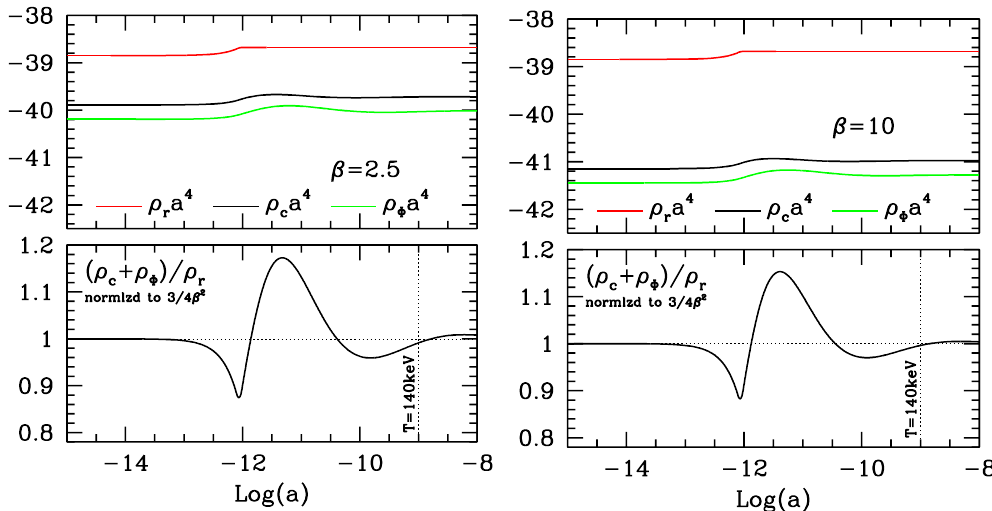
Figure 7. QH transition causes oscillations of the early density parameters Ω c = 2 Ω Φ = 1/2 β 2 . The system of Equation (11), when ρ r is given by expression (7), yields the results shown here for β = 2.5 and 10. In the upper frames, the logarithms of ρ r , c , Φ a 4 are plotted. Their deviation from the constant is also outlined in the lower frames. The normalized ratio ( ρ c + ρ Φ ) / ρ r exhibits a mild β dependence, in the initial oscillations, with maximum deviation by ∼ + 15%, + 18%, when T (cid:39) 20MeV, (if T c (cid:39) 150MeV). For the behaviors close to BBN, see the next figure.